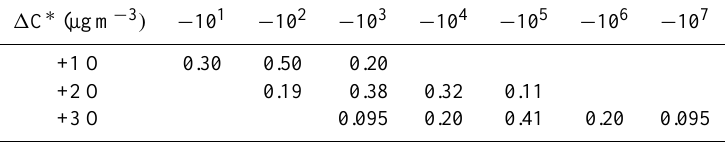
Table 1. Probability functions for the change in C ∗ when one to three oxygen atoms (O) are added to the organic compounds in the 2D-VBS. 1 C ∗ (µgm − 3